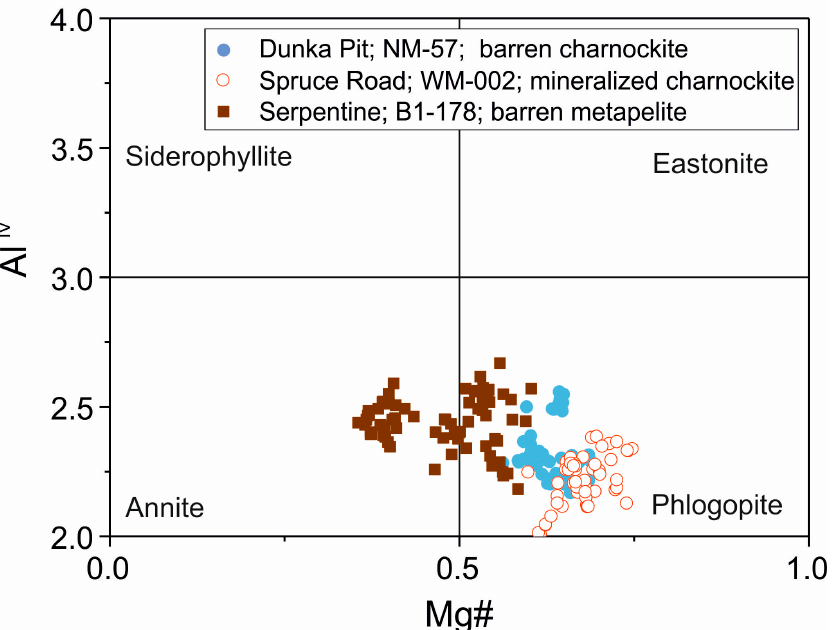
Figure 5. Classification of euhedral and subhedral biotite crystals that formed during the contact metamorphism based on Mg# and IV Al content (on an apfu basis).